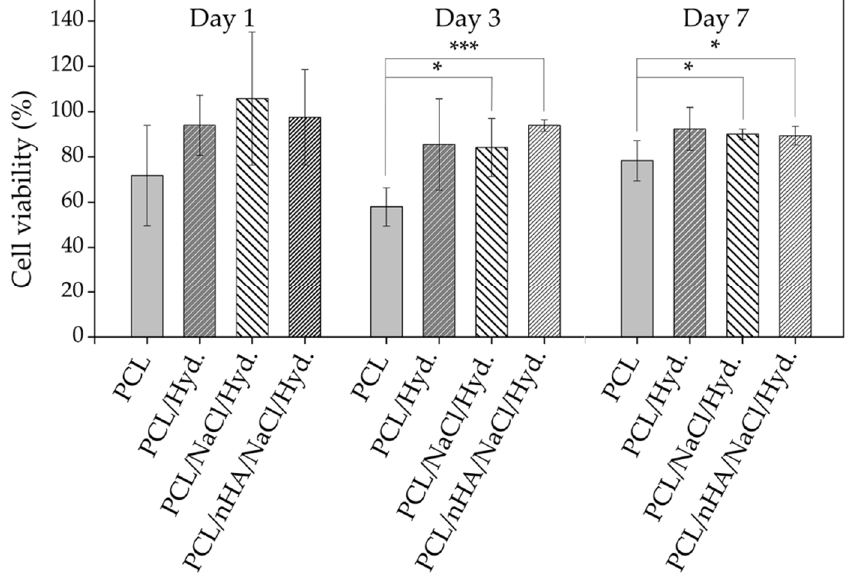
Figure 13. Cell viability studies obtained from AlamarBlue analysis for the samples PCL, PCL + Hydrogel, PCL/NaCl + Hydrogel, and PCL/nHA/NaCl + Hydrogel, for 1, 3, and 7 days incubation. Significant differences between the analyzed groups are indicated by * ( p -value ≤ 0.05) and *** ( p -value ≤